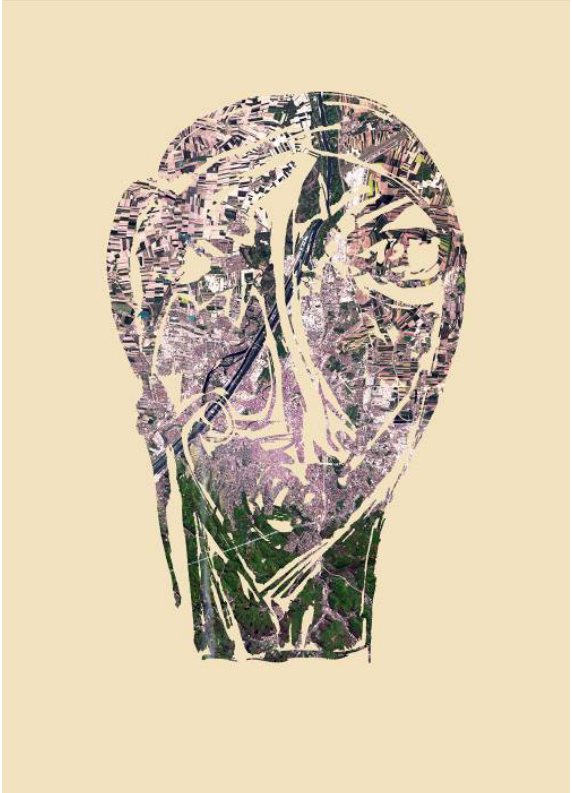
Figure 10 Tamer Assem – Vienna Woman – Digital Print – 70x50cm –